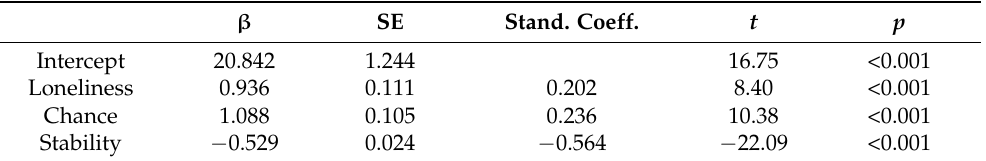
Table 3. Multiple regression analysis (beta weights, standard errors, standardized coefficients, t , and p -values) of the contributions of pandemic-associated concerns to psychological distress (HADS). β SE Stand. Coeff. t p Intercept 20.842 1.244 16.75 <0.001 Loneliness 0.936 0.111 0.202 8.40 <0.001 Chance 1.088 0.105 0.236 10.38 <0.001 Stability − 0.529 0.024 − 0.564 − 22.09 <0.001